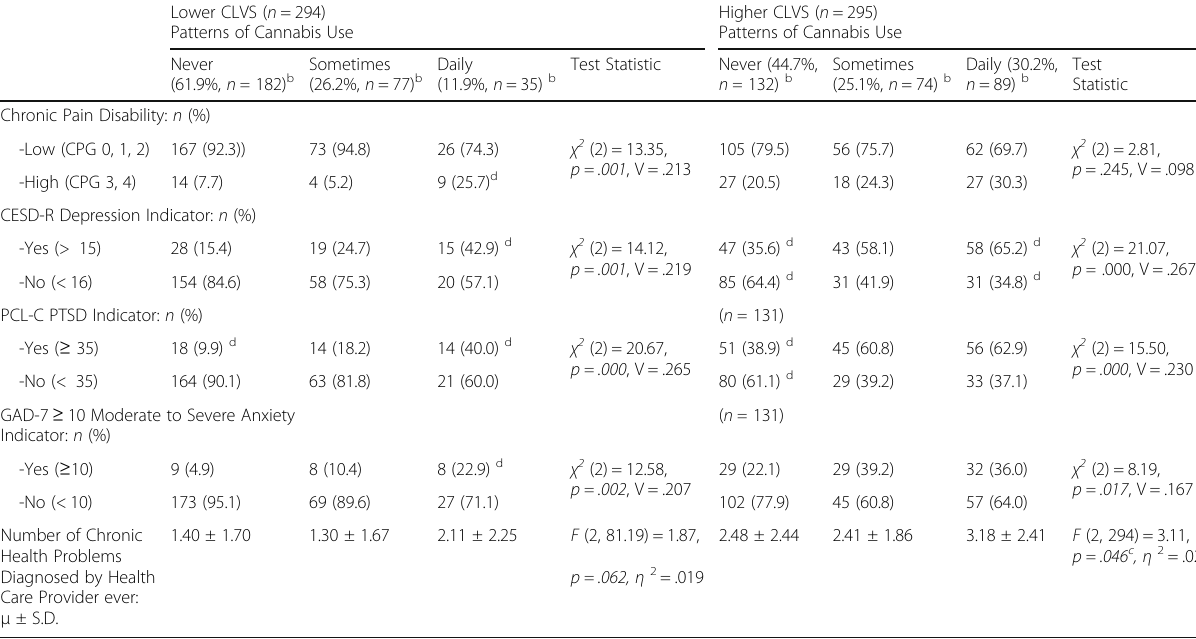
Table 6 Patterns of cannabis use in past year by health indicators by lower and higher CLVS a scale score groups Lower CLVS ( n =294) Higher CLVS ( n =295) Patterns of Cannabis Use Patterns of Cannabis Use Sometimes Daily Test Never (26.2%, n =77) b (11.9%, n =35) b (61.9%, n= 182) b